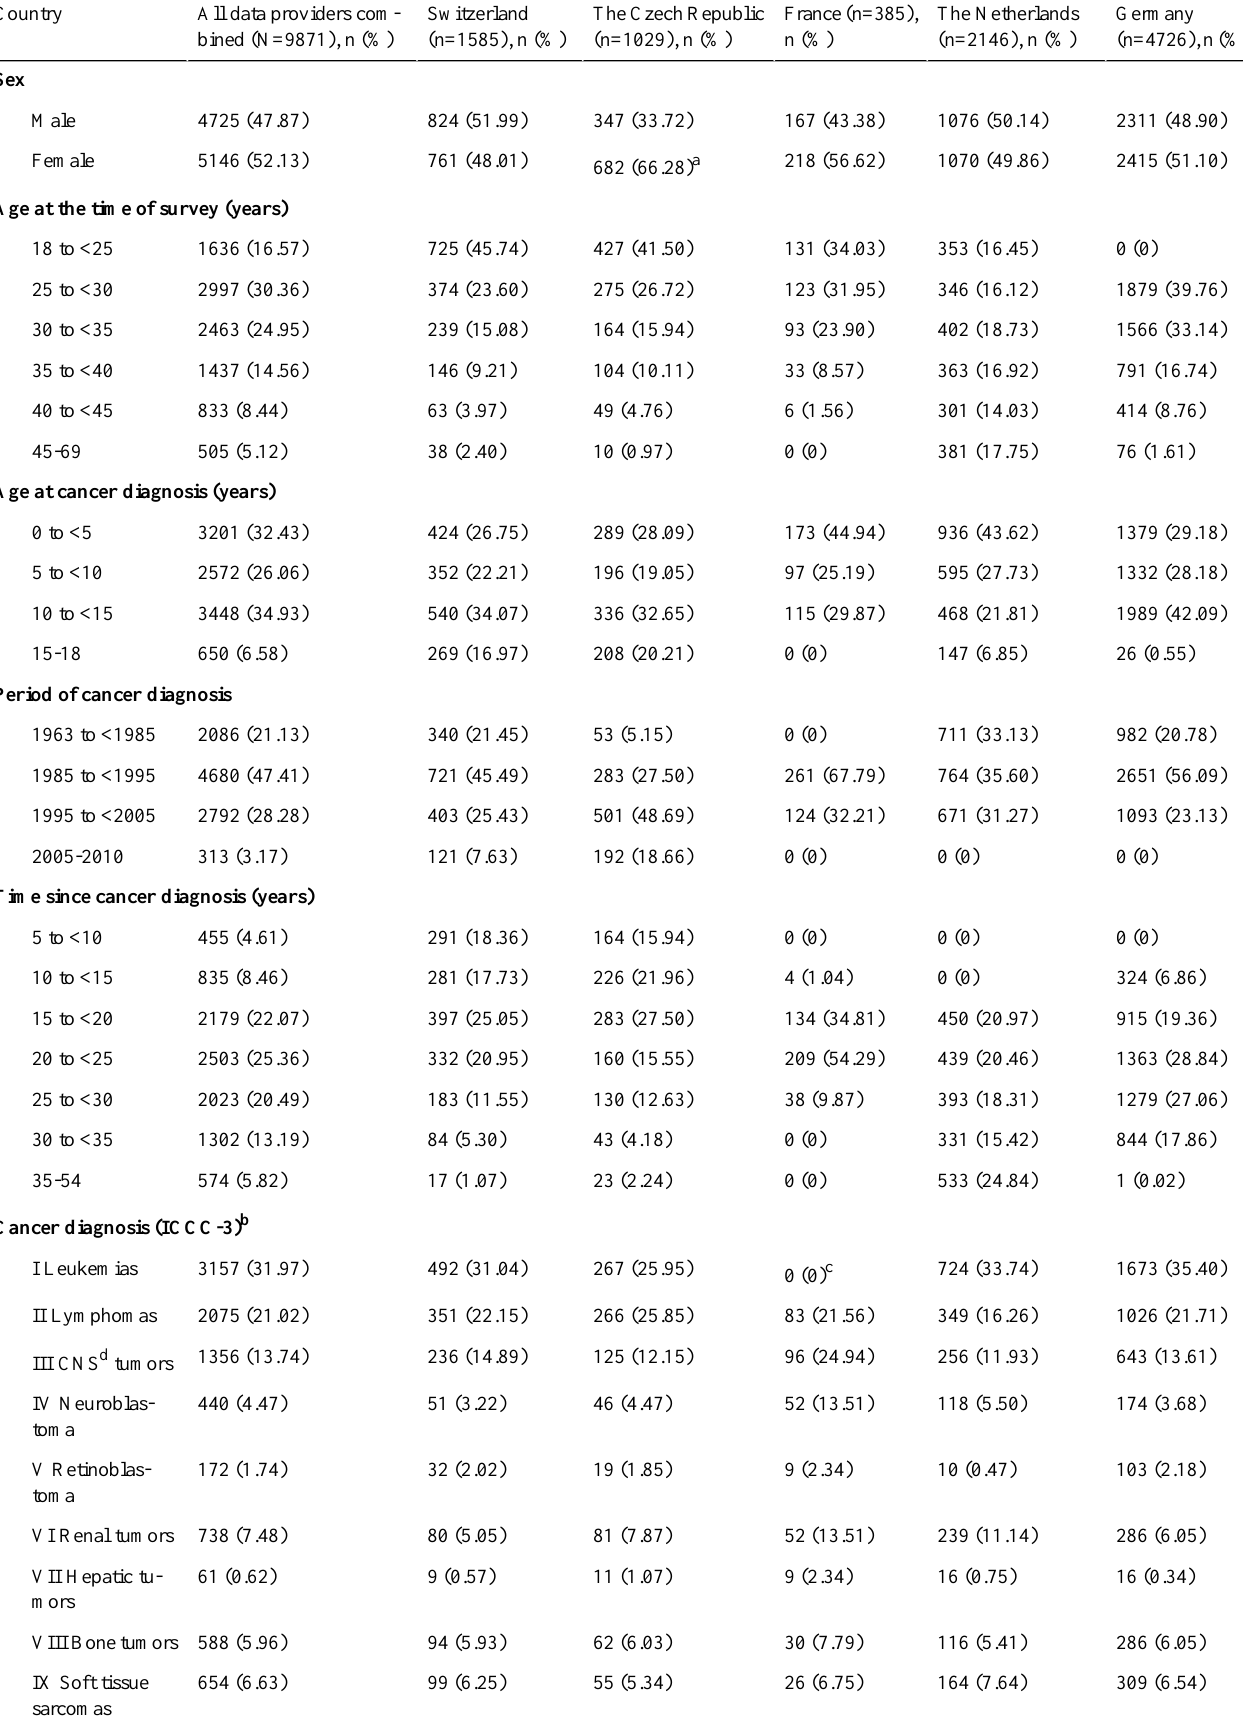
Table 5. Sociodemographic and medical characteristics of participating survivors, by country.